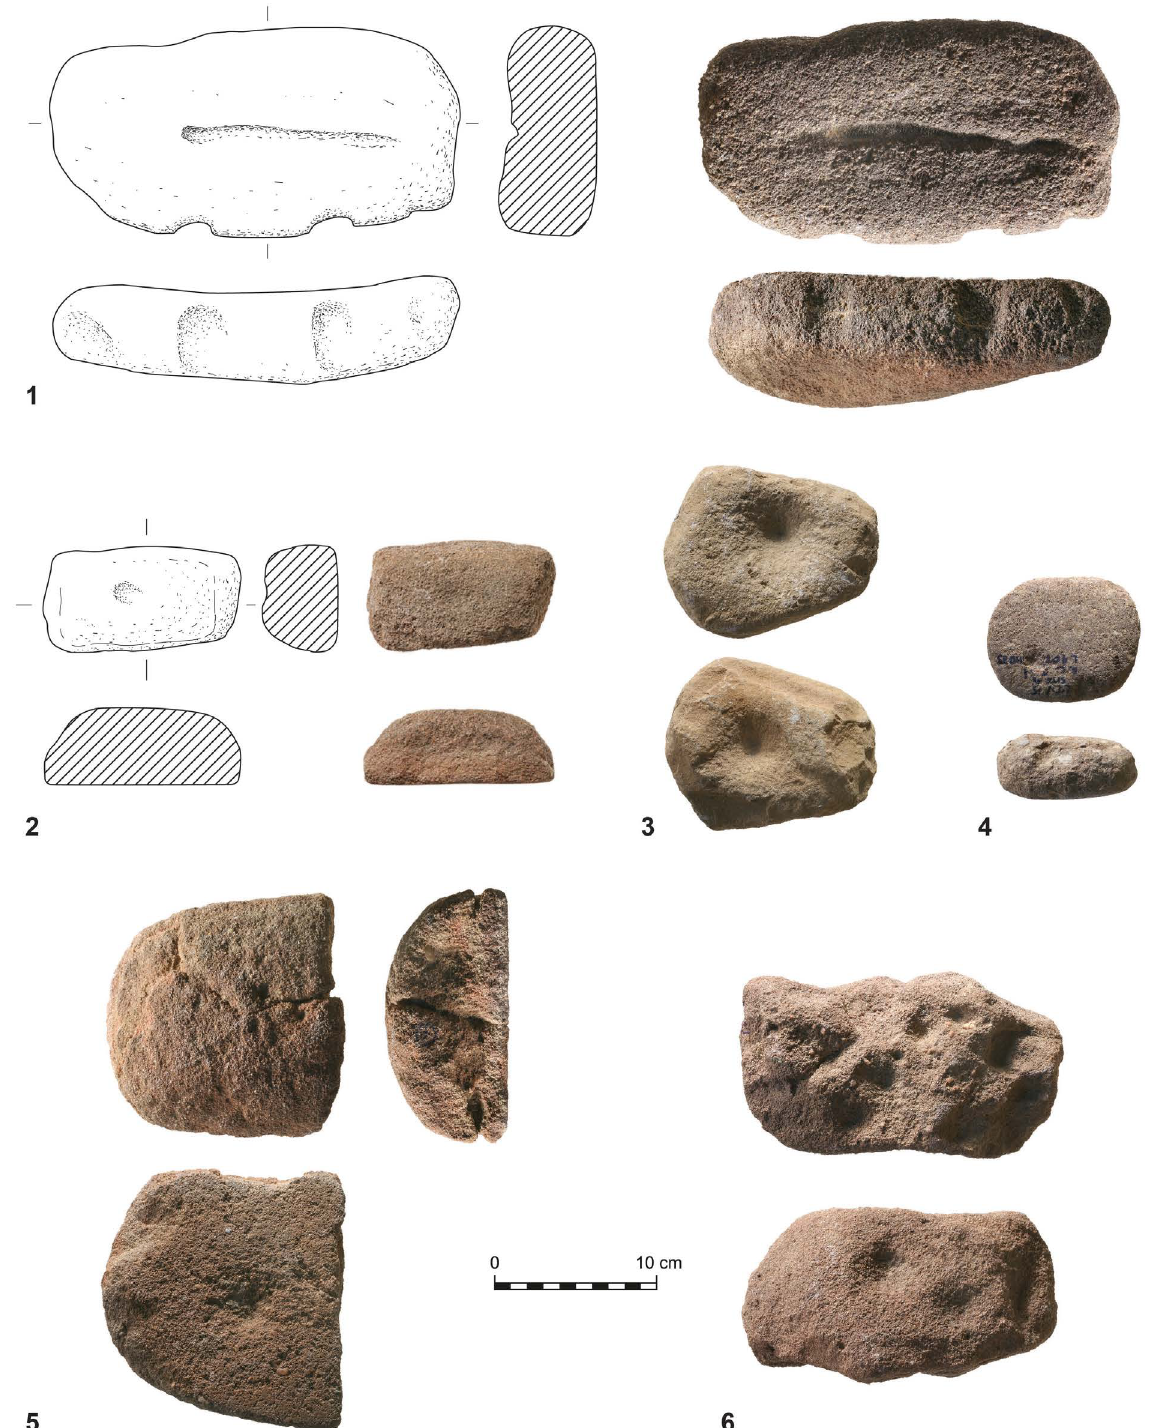
Figure 21. Various ground stone tools from Site 15. (1) B.6 (survey): lower (?) compacted coarse sandstone grinding stone with a groove and multiple dimples on sides and backside; (2) B.11003/2 (L.900, Area C): compacted sandstone rectangular polisher with a smooth surface; (3) B.7 (survey): limestone triangular pounder with dimples on both sides; (4) B.11033 (L.902, Area C): granite polisher; (5) B.4 (survey): lower “loaf shaped” grinding stone made of compacted coarse sandstone with dimples on the working surface; (6) B.14 (survey): irregular lower grinding stone made of compacted coarse sandstone, reused as an